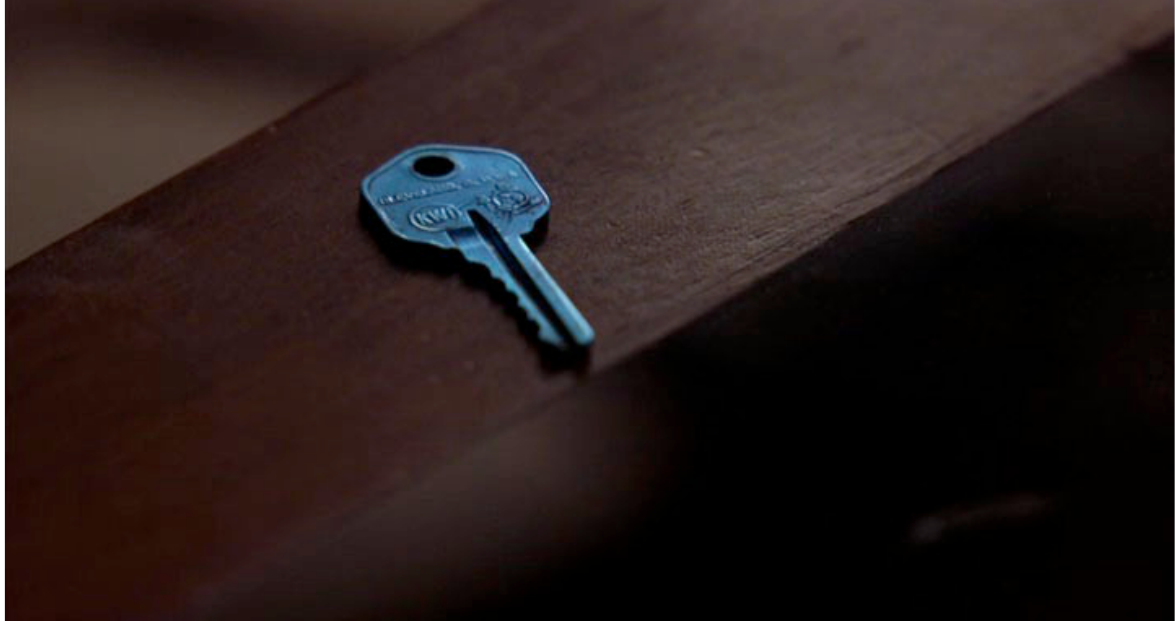
Figure 3: The key to Diane’s fantasies lurks in from time to time. In S1, Betty is Diane’s premature naive self and has anxieties about entering into the adult world. This results in a fixation on a premature sexual part, the breast. As soon as Betty and Rita fall in love and have sex, they start touching each other’s beasts, enjoying the experience. In S2, where we see Diane having sex with Camille, they try to engage in genital pleasure but Camille is extremely disturbed by this, just like masturbation, which gives a shock like a blurring of reality and fantasy in her